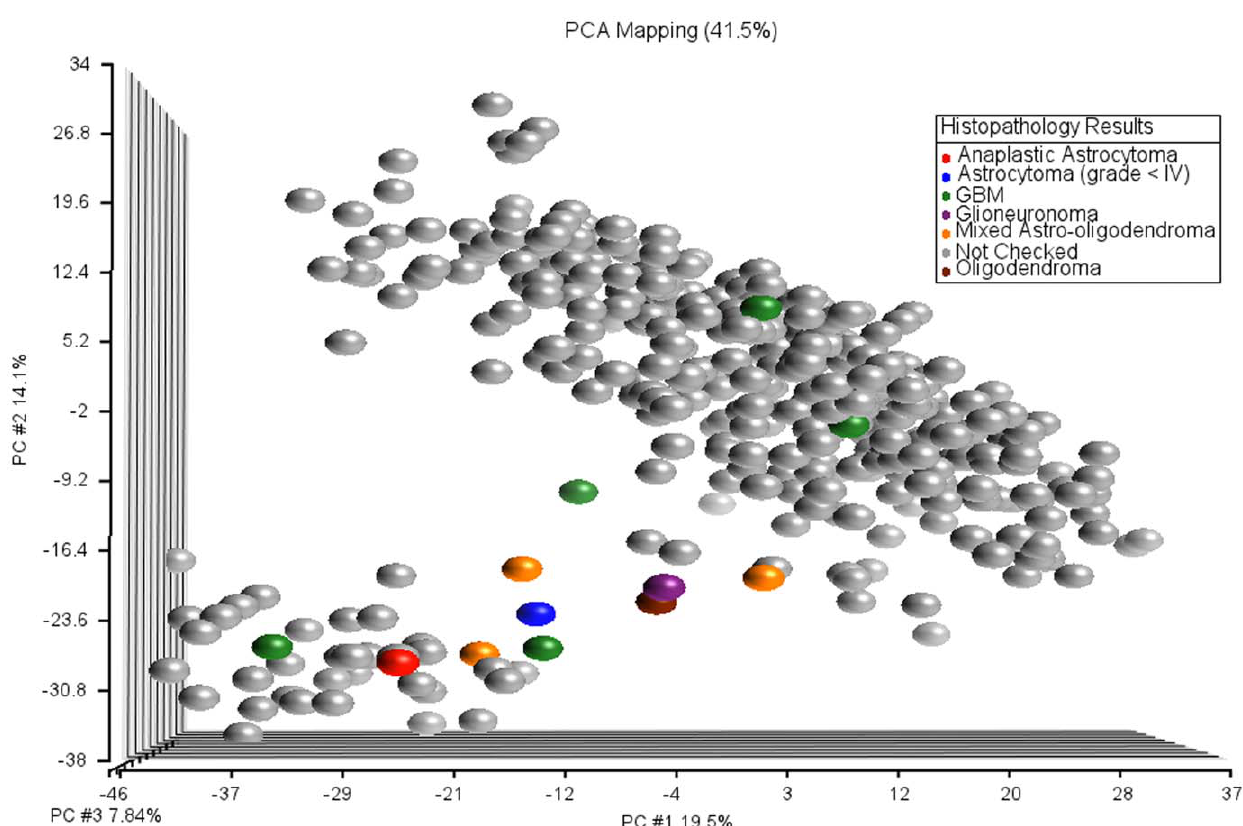
Figure 7. PCA plot of TCGA and NOB samples in combined methylation data set. Samples are labeled by histopathology check results.